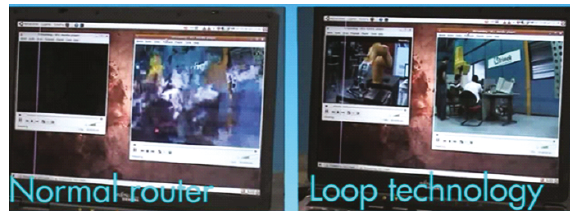
Figure 16: Router performance before versus after LOOP technol-